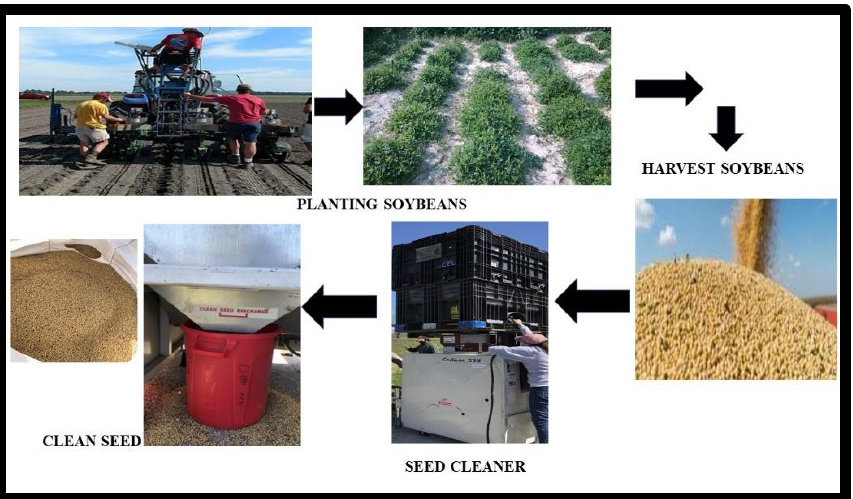
Figure 1 . Soybean Cultivation and Harvest Processing. Soybean cultivars are cultivated and har- vested. Post-harvest seeds are cleaned of all foreign material using an Eclipse 324 seed cleaner (images are taken from studies conducted by the Soybean Nitrogen and Fixation Unit, ARS, US Dept. of Agriculture, Raleigh, NC).